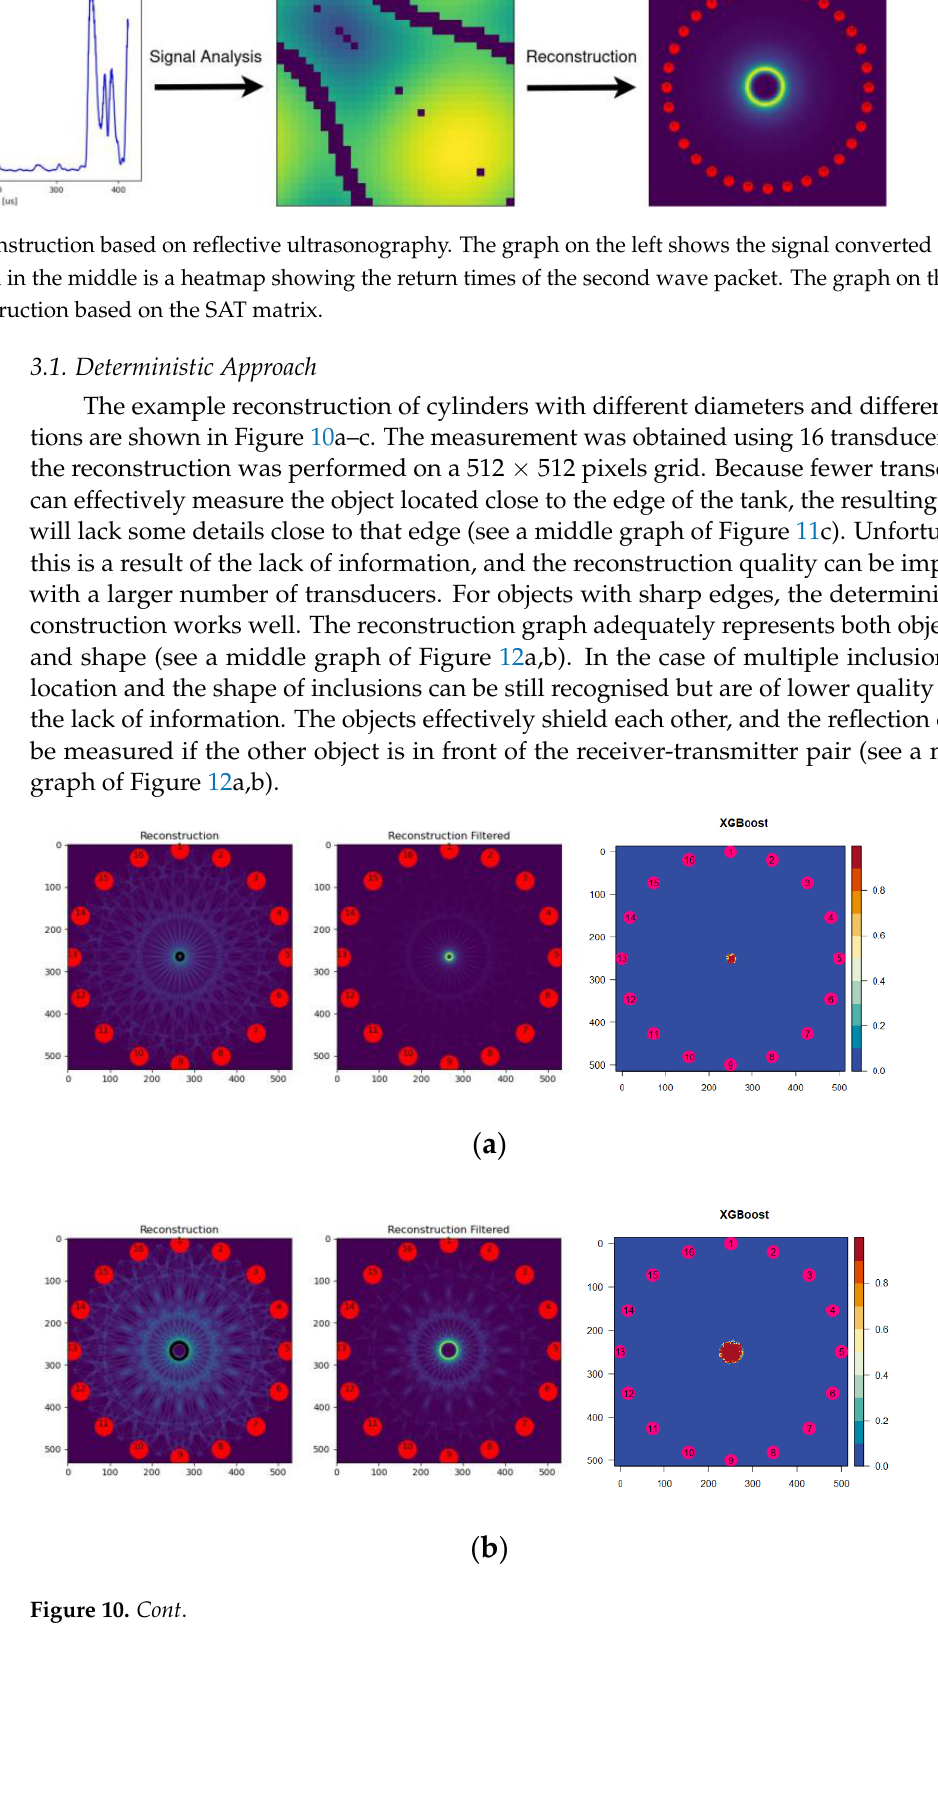
Figure 9. Two-stage reconstruction based on reflective ultrasonography. The graph on the left shows the signal converted to local variance. The graph in the middle is a heatmap showing the return times of the second wave packet. The graph on the right is an image reconstruction based on the SAT matrix.